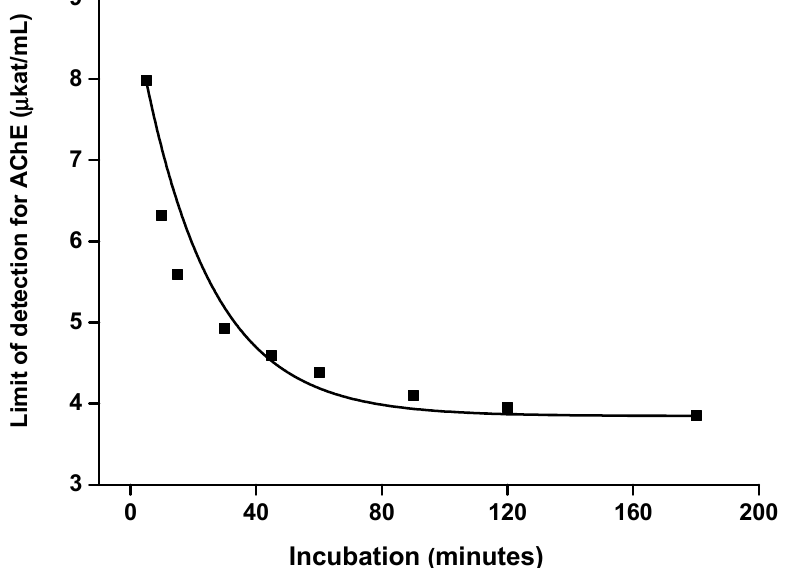
Figure 7. Effect of incubation time on the limit of detection when acetylcholinesterase (AChE) was measured by a camera-based colorimetric assay and the measuring pad was modified with indoxylacetate. R (red) channel was used for the assay. Standard error of the mean is expressed for five independent repeats.